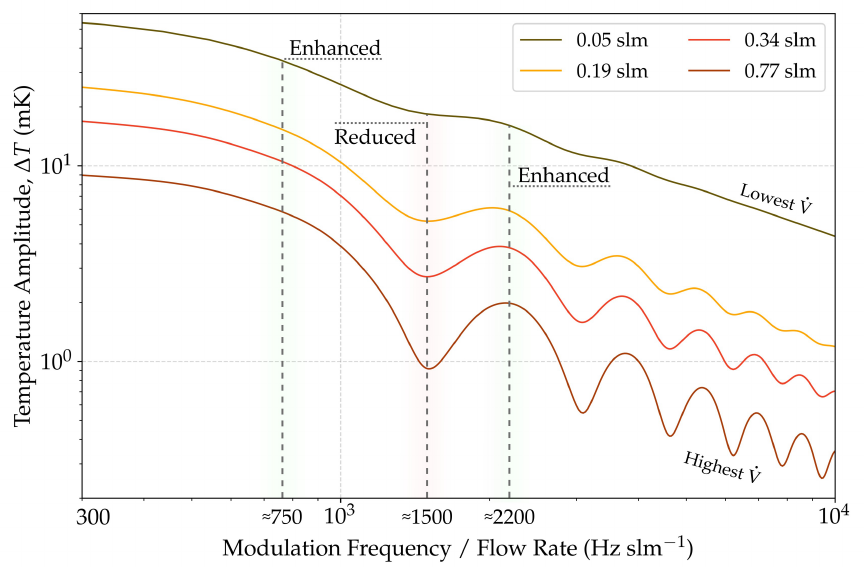
Figure 5. Temperature amplitude as a function of the ratio between modulation frequency and mass flow rate for four selected mass flow rates ˙ V . Areas with greater temperature amplitude and areas with reduced amplitude appear, which are more pronounced towards larger ˙ V . The temperature amplitude is averaged over the entire channel